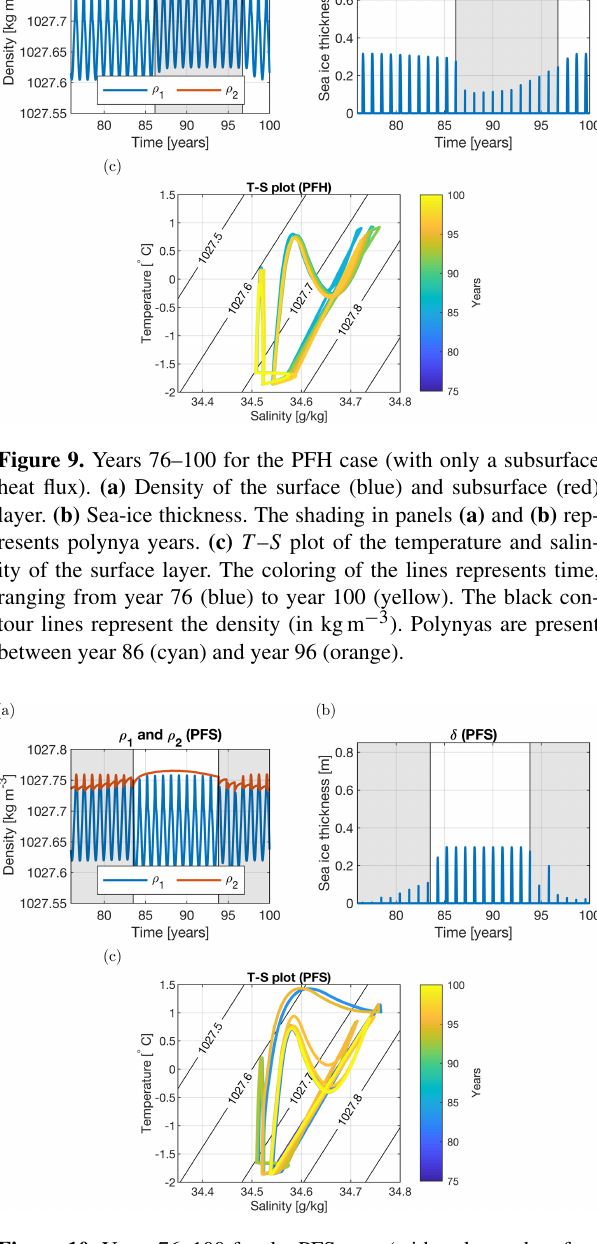
Figure 10. Years 76–100 for the PFS case (with only a subsurface salt flux). (a) Density of the surface (blue) and subsurface (red) layer. (b) Sea-ice thickness. The shading in panels (a) and (b) rep- resents polynya years. (c) T – S plot of the temperature and salinity of the surface layer. The coloring of the lines represents time, rang- ing from year 76 (blue) to year 100 (yellow). The black contour lines represent the density (in kgm − 3 ). Polynyas are present be- tween year 76 (blue) and 83 (cyan) as well as after year 94 (orange to